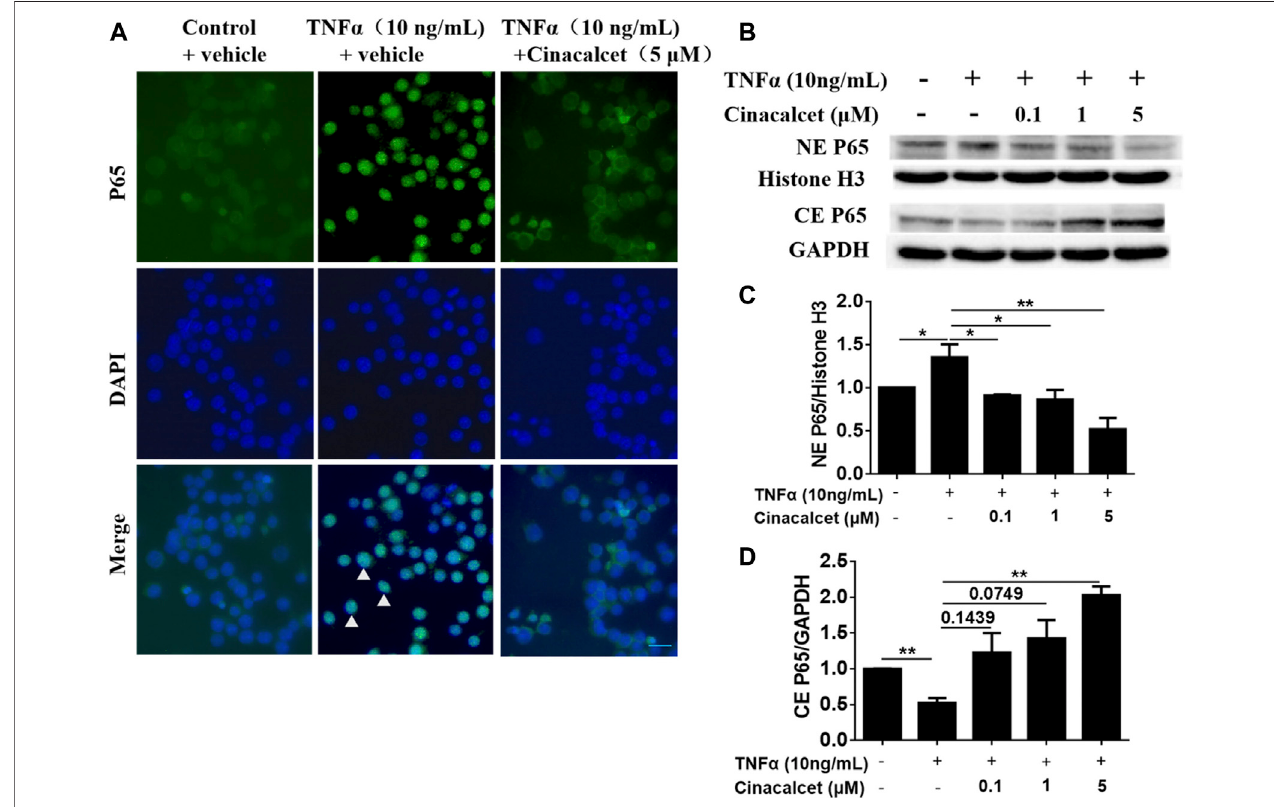
FIGURE 5 | Cinacalcet inhibits the translocation of P65 from the cytoplasm to the nucleus. (A) RAW264.7 cells were starved with 2% FBS overnight. After treating the cells with cinacalcet (5 μ M) for 2 h, TNF α (10 ng/ml) was added for 4 h. Immuno fl uorescence of P65 was performed (20 μ m). White arrow heads indicate the aggregation ofP65 in the nuclei. (B) Bone marrow-derived macrophages (BMDMs) were seeded in 10 cm plates. After starvation with 2% FBS overnight, the cells were treated with cinacalcet (0.1, 1, 5 μ M) for 2 h followed by TNF α (10 ng/ml) for 45 min. Cytoplasmic and nuclear proteins were extracted for western blotting. (C) Quanti fi cation of NE P65 expression standardized to the internal expression of histone H3. (D) Quanti fi cation of CE P65 expression standardized to the internal expression of GAPDH. * p < 0.05, ** p < 0.01. Data are shown as the mean with standard deviation. Three independent experiments were performed.